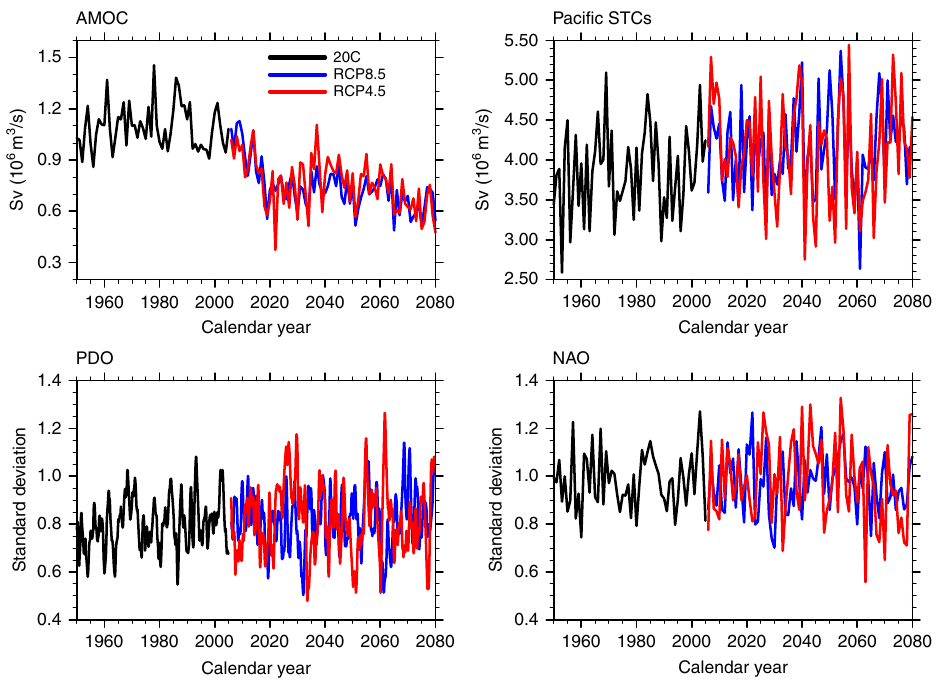
Fig. 6 Time evolving intra-ensemble standard deviation for a given internal climate processes. AMOC Atlantic Meridional Overturning Circulation, Paci fi c STCs Paci fi c Subtropical Cells, PDO Paci fi c Decadal Oscillation, and NAO North Atlantic Oscillation. Black lines represent the intra-ensemble standard deviation for the twentieth century (1920 – 2005); blue lines are the intra-ensemble standard deviation for RCP8.5 (2006 – 2080); and red lines the intra- ensemble standard deviation for RCP4.5 (2006 –